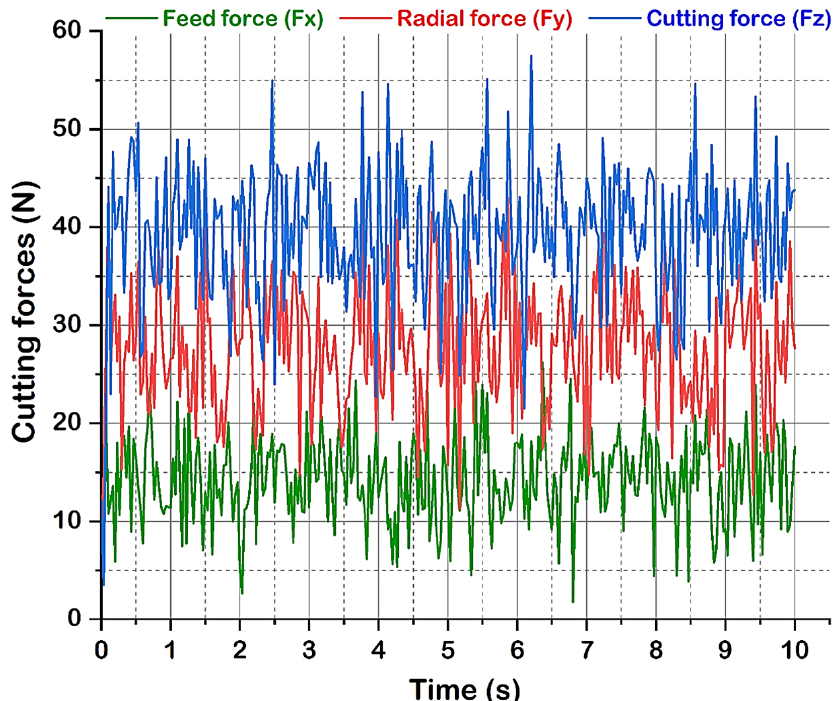
Figure 7. Cutting forces (F x , F y , F z ) at experimental run order 4 (V = 112 m/min, f = 0.28 mm/rev, d = 0.40 mm).